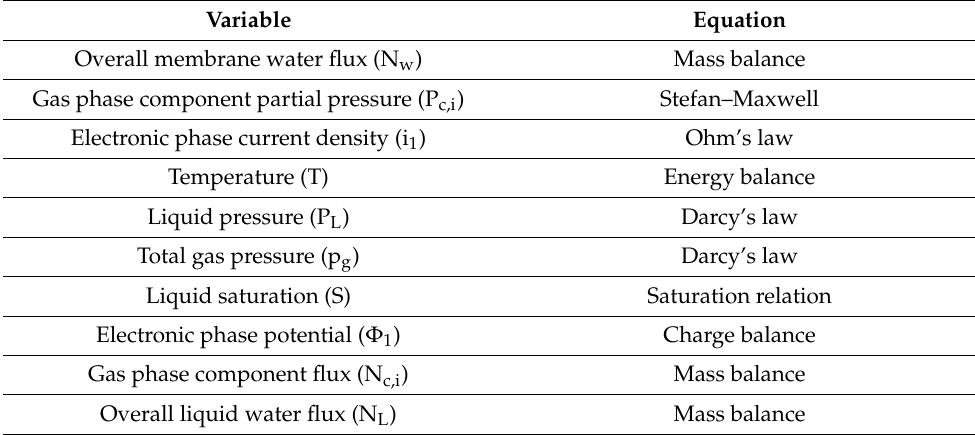
Table 4. Main Design Parameters in the GDL Model (Adapted from